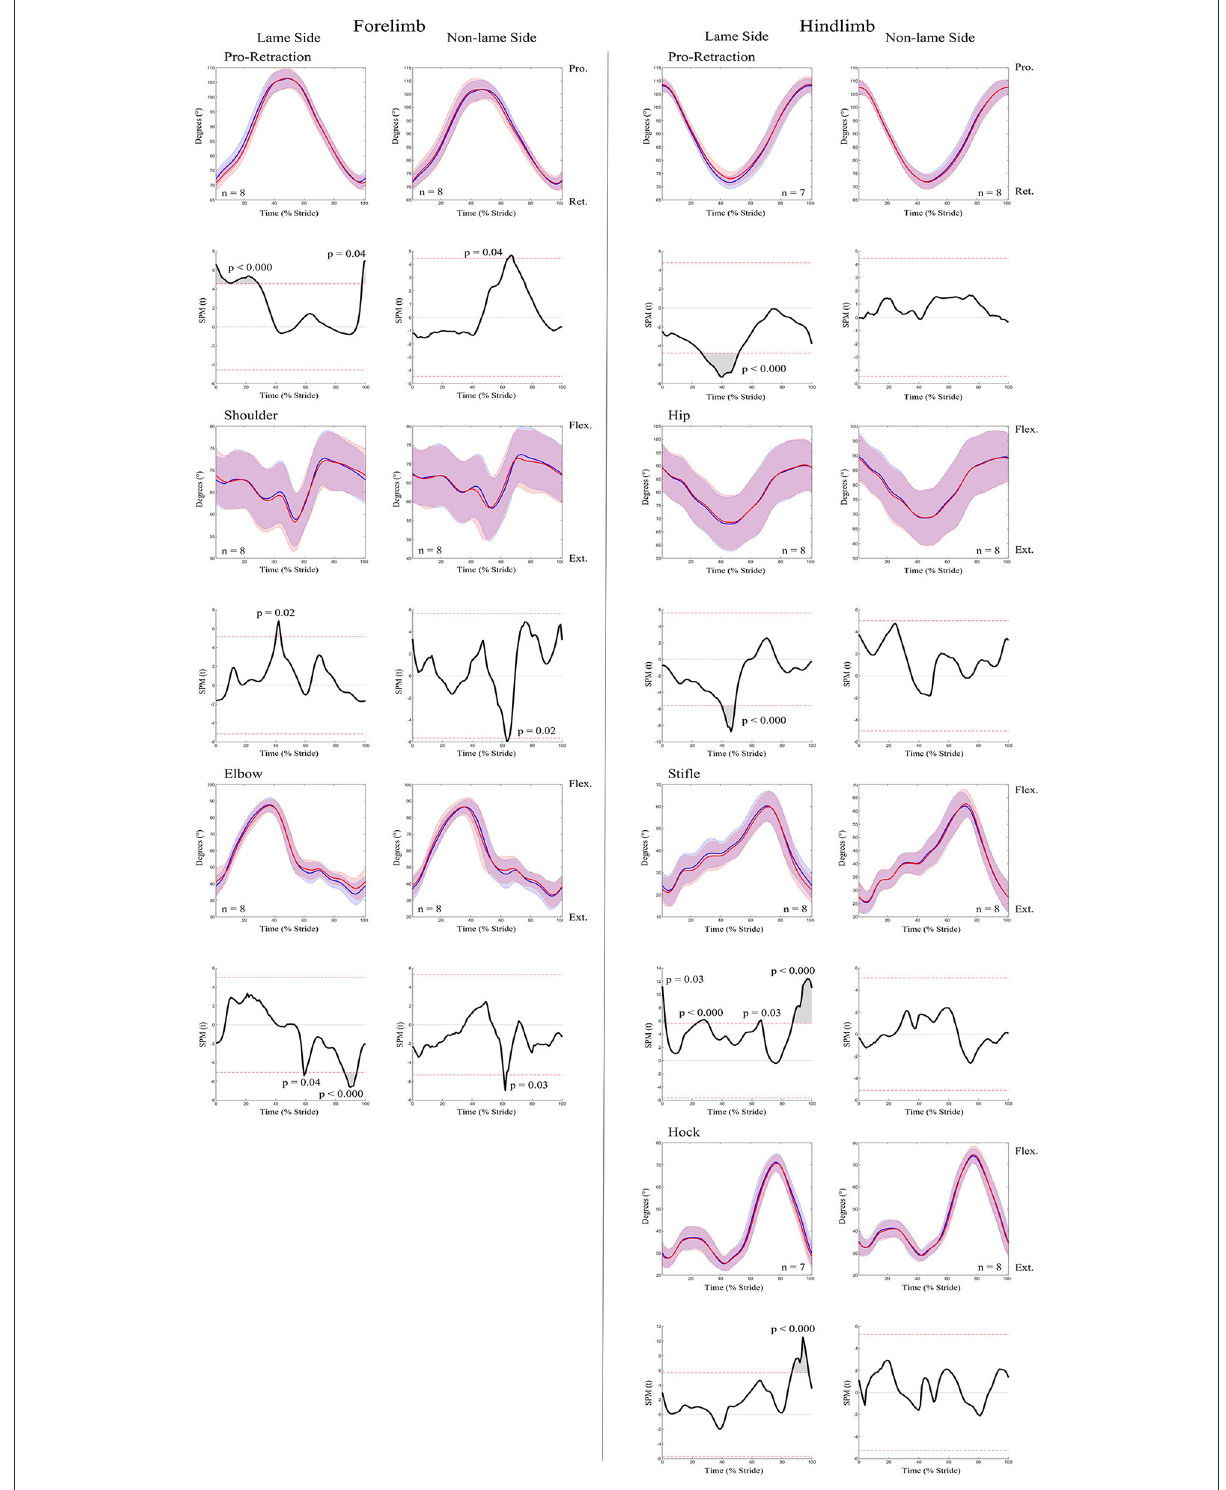
FIGURE4 SPM results for time-normalized kinematic data across the group of horses ( n = 8) for sagittal plane joint angles and pro-retraction angles of the forelimb (Left panel) and hindlimb (Right panel) during baseline 1 (blue solid lines/shaded area) and induced forelimb lameness (red